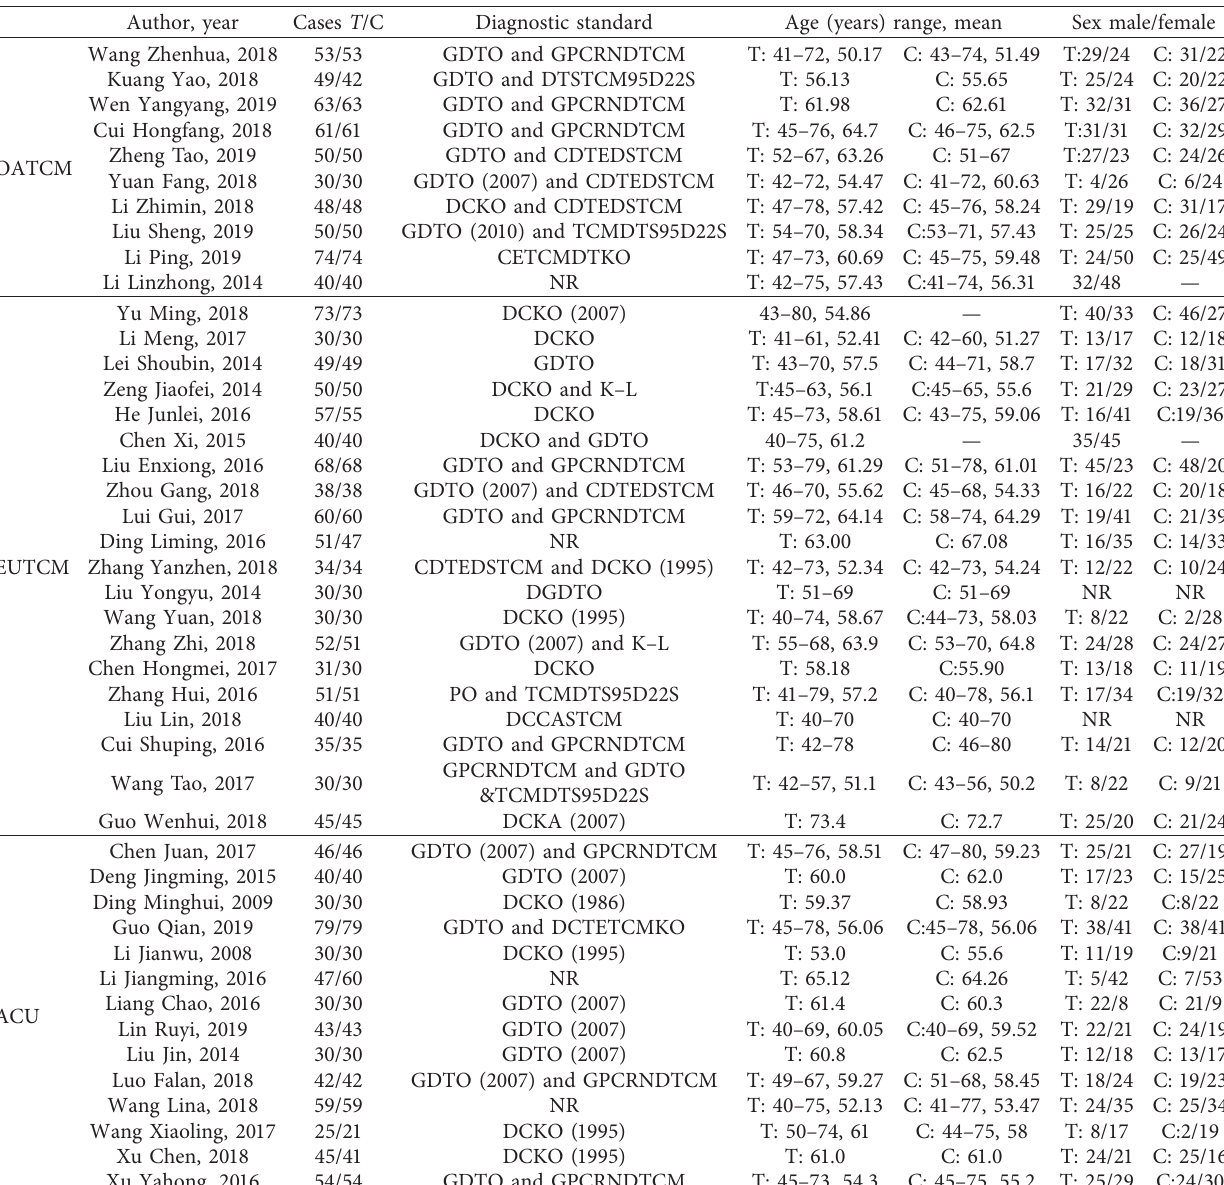
Table 1: Characteristics of eligible